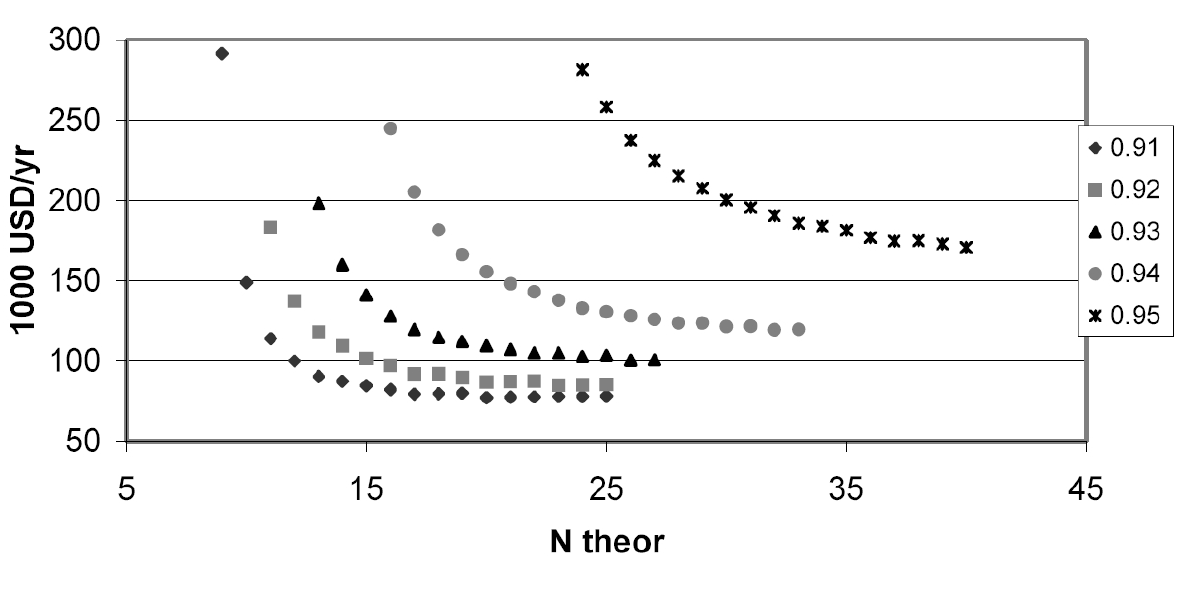
Fig. 10 Cost of distillation